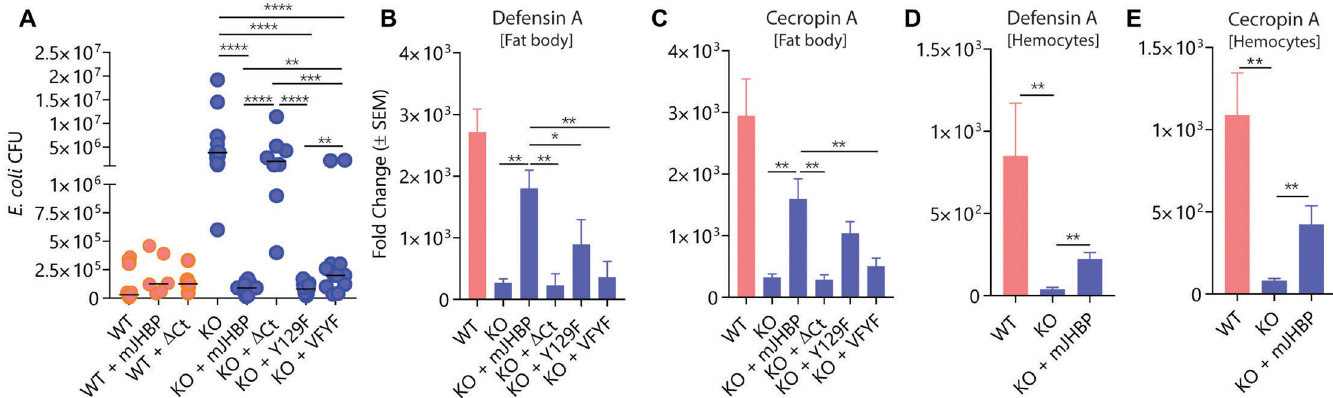
Fig 6. Effect of wild type and mutant mJHBP protein injection on bacterial replication and induction of antimicrobial peptides in fat bodies and hemocytes from E . coli -challenged females. Data shown in A-C compares the activity of wild type mJHBP protein and three JH-binding deficient mutants. A. The ability of mJHBP site- directed mutants to rescue the ability of mJHBP -/- ( KO ) mosquitoes to control bacterial infection correlates with JH binding capability measured in ITC experiments. The order of immunomodulatory potency for the proteins is: WT > Y129F > VFYF > Δ Ct. The responses of infected WT females are shown for comparison. Statistical comparisons are shown between buffer-injected females and females injected with WT mJHBP or its mutants. Significance levels (Mann-Whitney U test) are indicated with asterisks ( ���� p � 0.0001, ��� � 0.001, �� � 0.01). Sample sizes: WT (n = 13, 4 biological replicates), WT +mJHBP (n = 6, 3 replicates), WT + Δ Ct (n = 6, 3 replicates), KO (n = 11, 3 replicates), KO +mJHBP (n = 12, 4 replicates), KO + Δ Ct (n = 8, 3 replicates), KO +Y129F (n = 15, 5 replicates), KO +YFVF (n = 12, 4 replicates). Median values are shown as horizontal lines. The injection of biologically active mJHBP into mJHBP -/- ( KO ) mosquitoes rescues the early induction of the AMPs defensin A ( B ) and cecropin A ( C ) in the fat body at 24 h after bacterial infection. AMP expression in protein-injected, E . coli -infected mosquitoes was determined relative to protein-injected, HBSS-injected (no infection) individuals by quantitative PCR using the 2 - ΔΔ Ct method. Site-directed mutant proteins vary in effectiveness in restoring AMP production corresponding to their JH III binding affinity (WT > Y129F > VFYF > Δ Ct). The response of infected WT females is shown for comparison. Sample sizes: WT (n = 6, 3 biological replicates), KO (n = 6, 3 replicates), KO +mJHBP (n = 7, 3 replicates), KO + Δ Ct (n = 6, 3 replicates), KO +Y129F (n = 6, 3 replicates), KO +VFYF (n = 6, 3 replicates). Treatments were compared using the Mann-Whitney U test ( �� p � 0.01, � � 0.05). The injection of biologically active mJHBP into KO mosquitoes rescues the early induction of the antimicrobial peptides defensin A ( D ) and cecropin A ( E ) in hemocytes at 24 h after bacterial infection. Sample sizes: (n = 6, 3 biological replicates). Data were analyzed using the Mann-Whitney U test ( �� p �